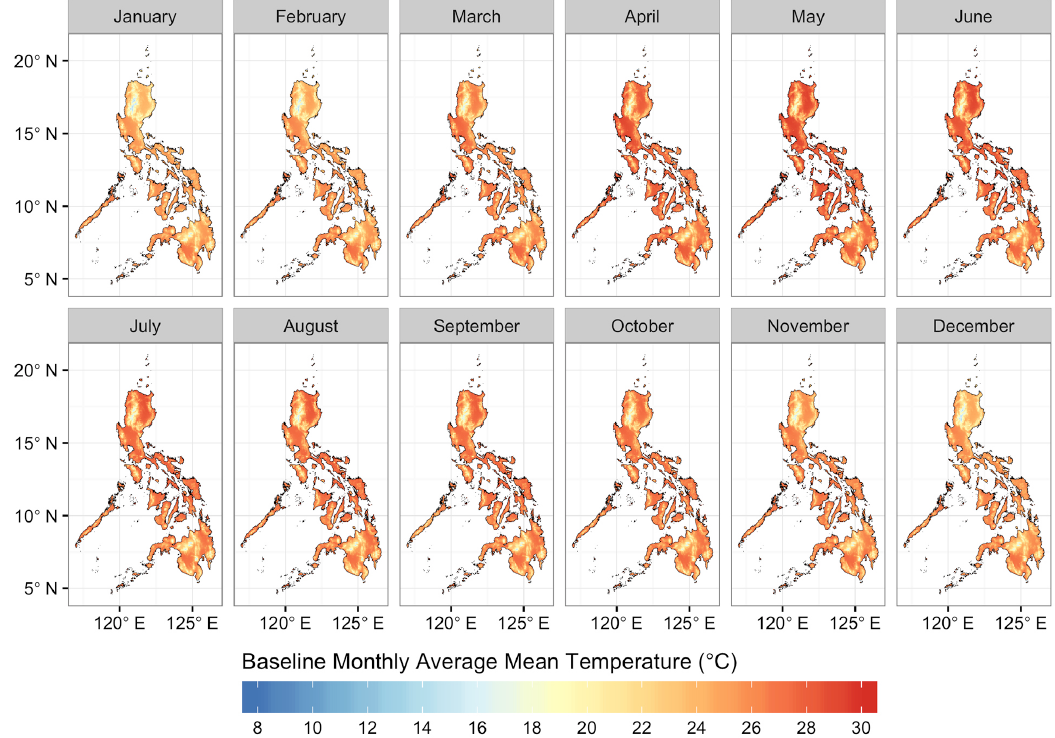
Fig. 3. Spatial distribution of average mean monthly temperature in the Philippines under baseline climate condition